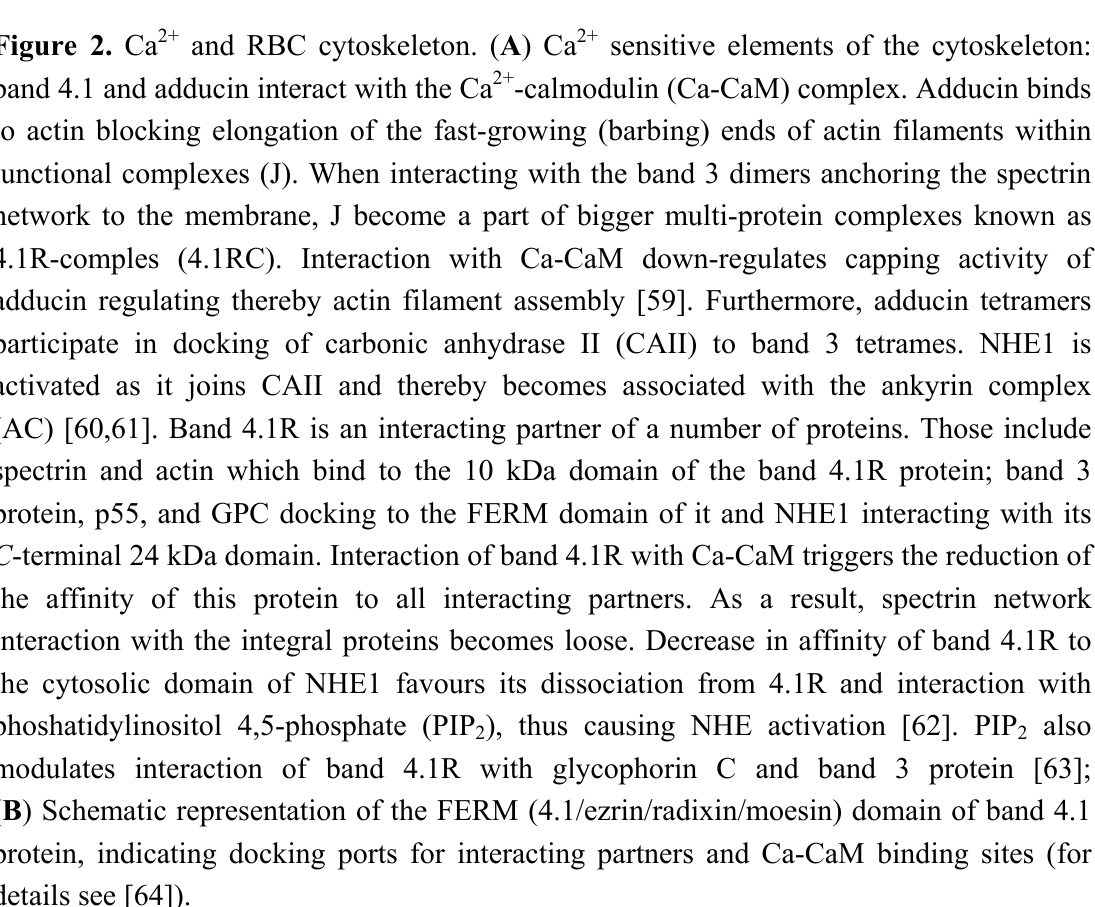
Figure 2. Ca 2+ and RBC cytoskeleton. ( A ) Ca 2+ sensitive elements of the cytoskeleton: band 4.1 and adducin interact with the Ca 2+ -calmodulin (Ca-CaM) complex. Adducin